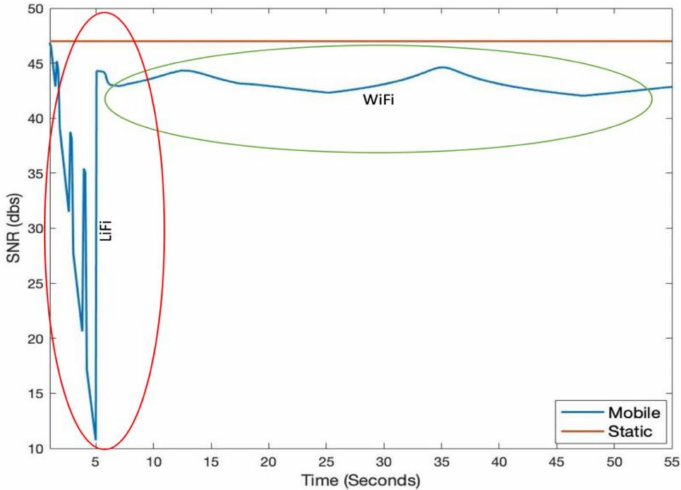
Figure 6. Instantaneous SNR for hybrid LiFi/WiFi system.